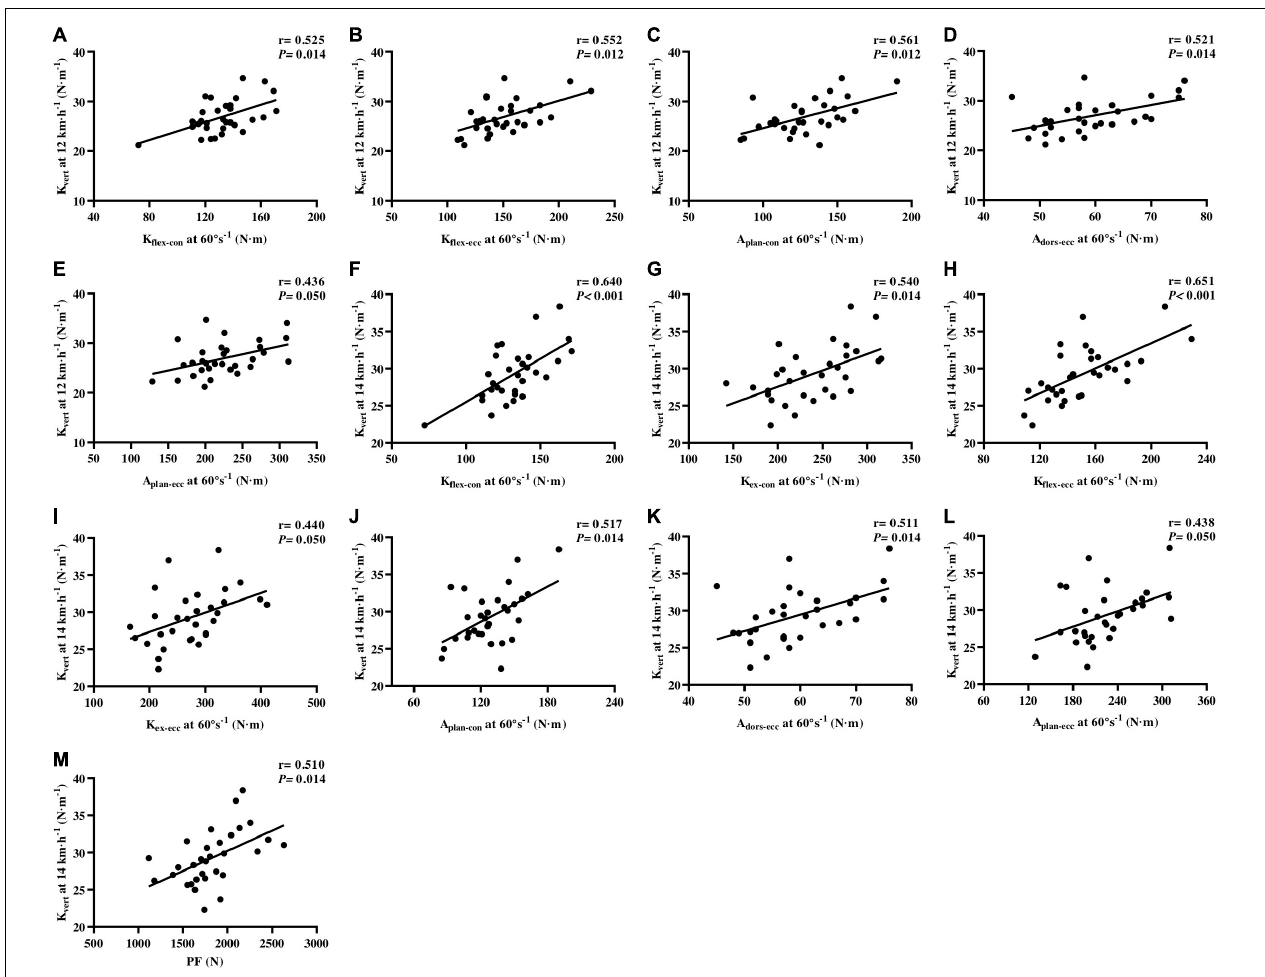
FIGURE 5 | Correlations of isokinetic lower-limb joint strength and IMTP force-time characteristics vertical stiffness at running speeds of 12 and 14 km · h − 1 (A–M) . K flex − con , knee flexor muscles peak torque in concentric action; K ex − con , knee extensor muscles peak torque in concentric action; K flex − ecc , knee flexor muscles peak torque in eccentric action; K ex − ecc , knee extensor muscles peak torque in eccentric action; A plan − con , plantar flexor muscles peak torque in concentric action; A dors − ecc , dorsiflexor muscles peak torque in eccentric action; A plan − ecc , plantar flexor muscles peak torque in eccentric action; PF, peak force; IMTP, isometric mid-thigh